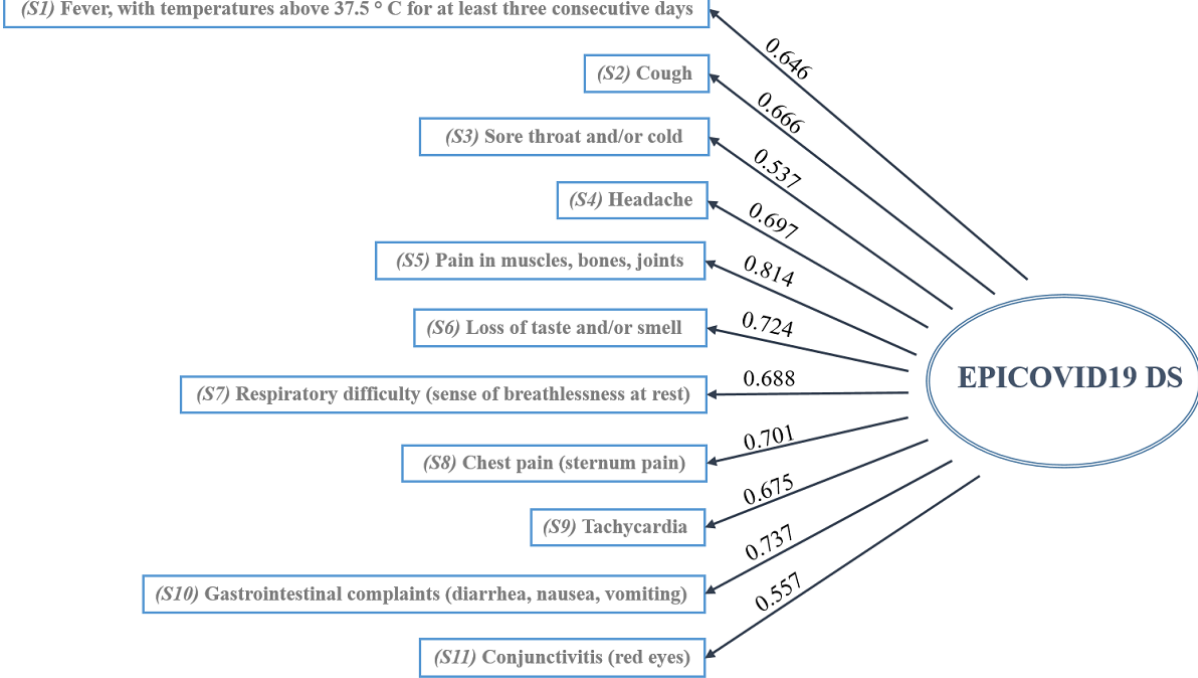
Horn parallel analysisPrincipal-component factors analysis